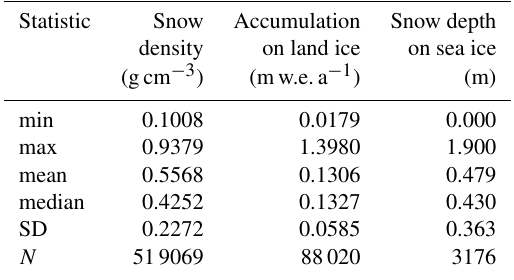
Table 5. The descriptive statistics for all of the Antarctic measure- ments in SUMup, including the minimum (min), maximum (max), mean, median, standard deviation (SD), and number of measure- ments ( N